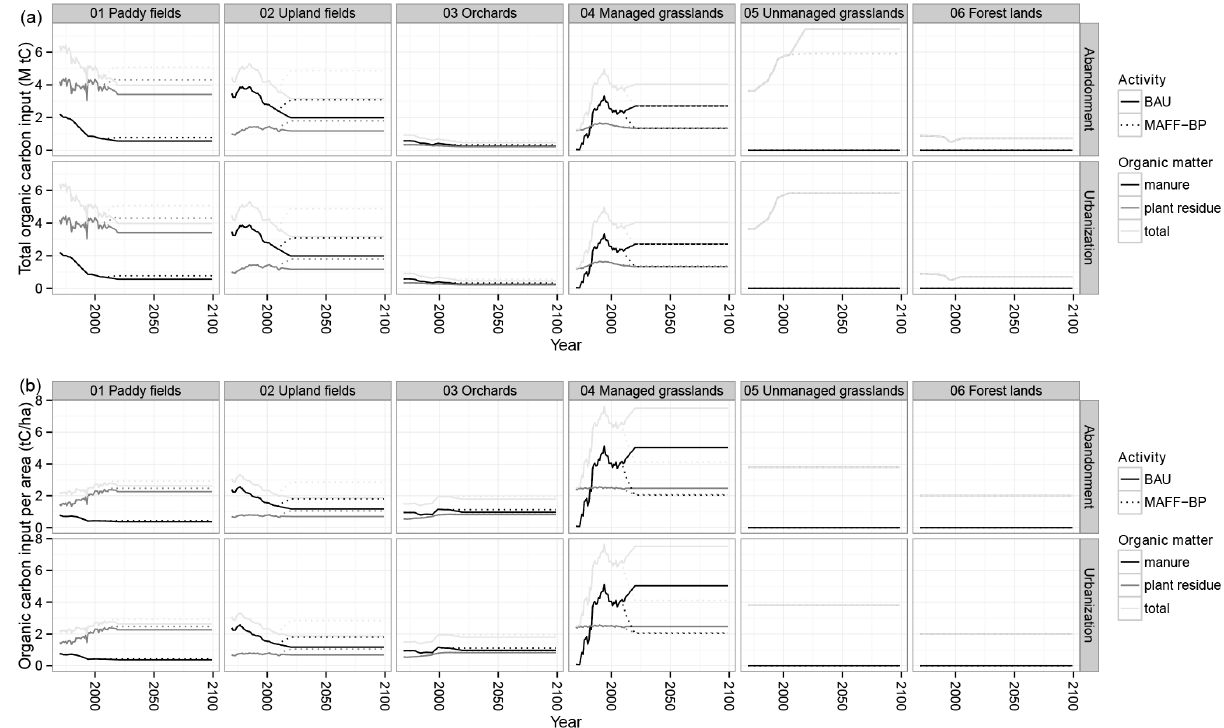
Figure 4. Input of organic carbon to soils expressed as annual total sum (a) and annual input rate per unit area of soils (b) in different land- use types (lined up horizontally) under different scenarios of future land-use change (abandonment and urbanization; lined-up vertically) in periods including historical (1970–2006), future scenarios during 2007–2020 with varying input rate toward target or predicted levels in 2020, and subsequent future period in 2021–2099 with assuming no change in input rate after 2020. Overall input (sum of plant residue, manure, slurry and excreta), plant residue, and sum of manure, slurry, and excreta are indicated in very light gray, light gray, and black colour, respectively. Solid and dashed line indicates future agricultural activity scenario BAU and MAFF-BP,